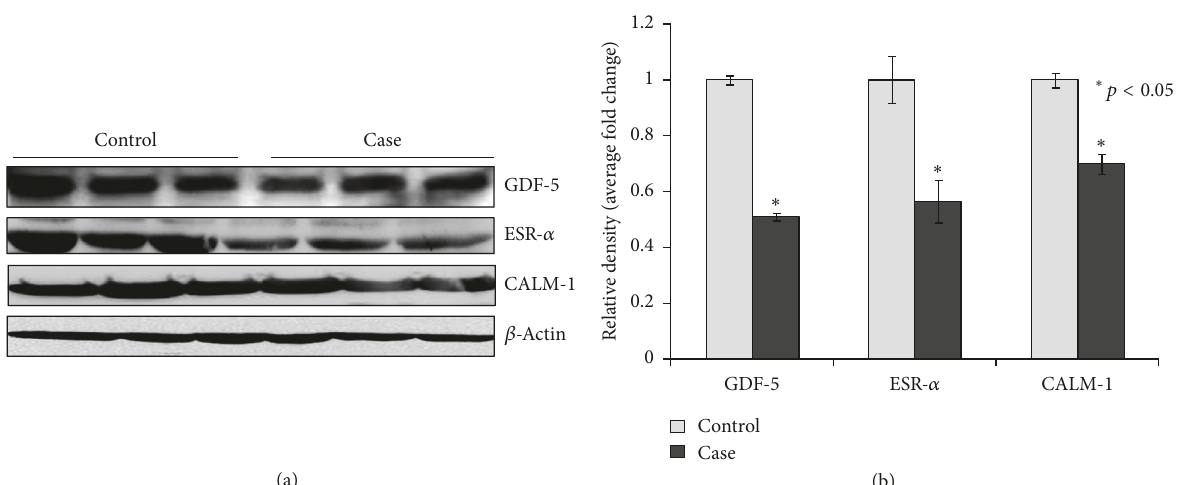
Figure 3: (a) Western blot analysis was performed to understand the protein level of GDF5, ESR- 𝛼 , and CALM-1 in control and case study. (b) Bar diagram showing the relative protein density after normalization with 𝛽 -actin. Relative protein density of GDF5, ESR- 𝛼 , and CALM-1 was significantly decreased in case study as compared to control group. Representative blots showing three samples from each group (control and case). Values are expressed as mean ± SEM ( 𝑛 = 24 ). ∗ 𝑝 < 0.05 versus